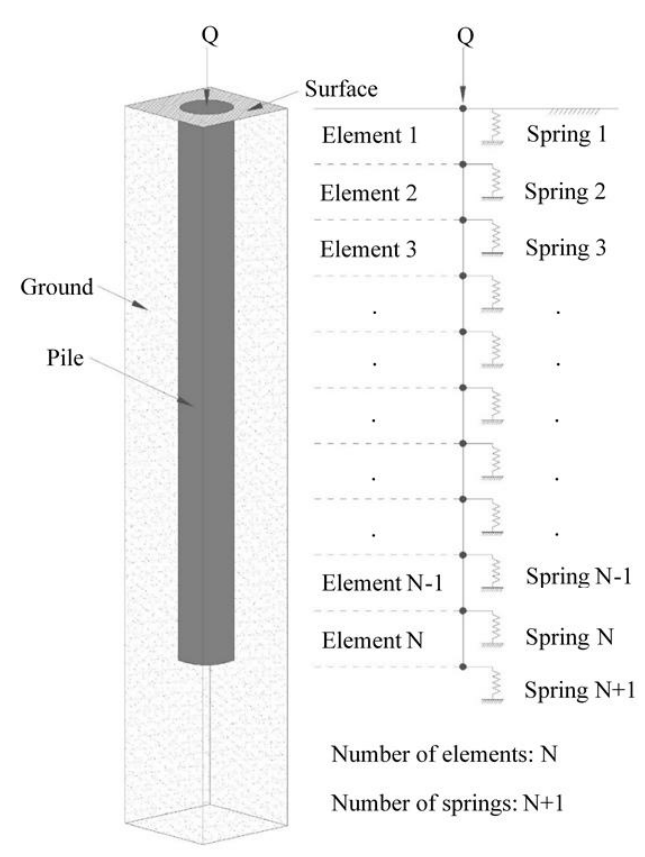
Figure 1. Pile ( left ) and finite element representation of the pile–soil system ( right ).